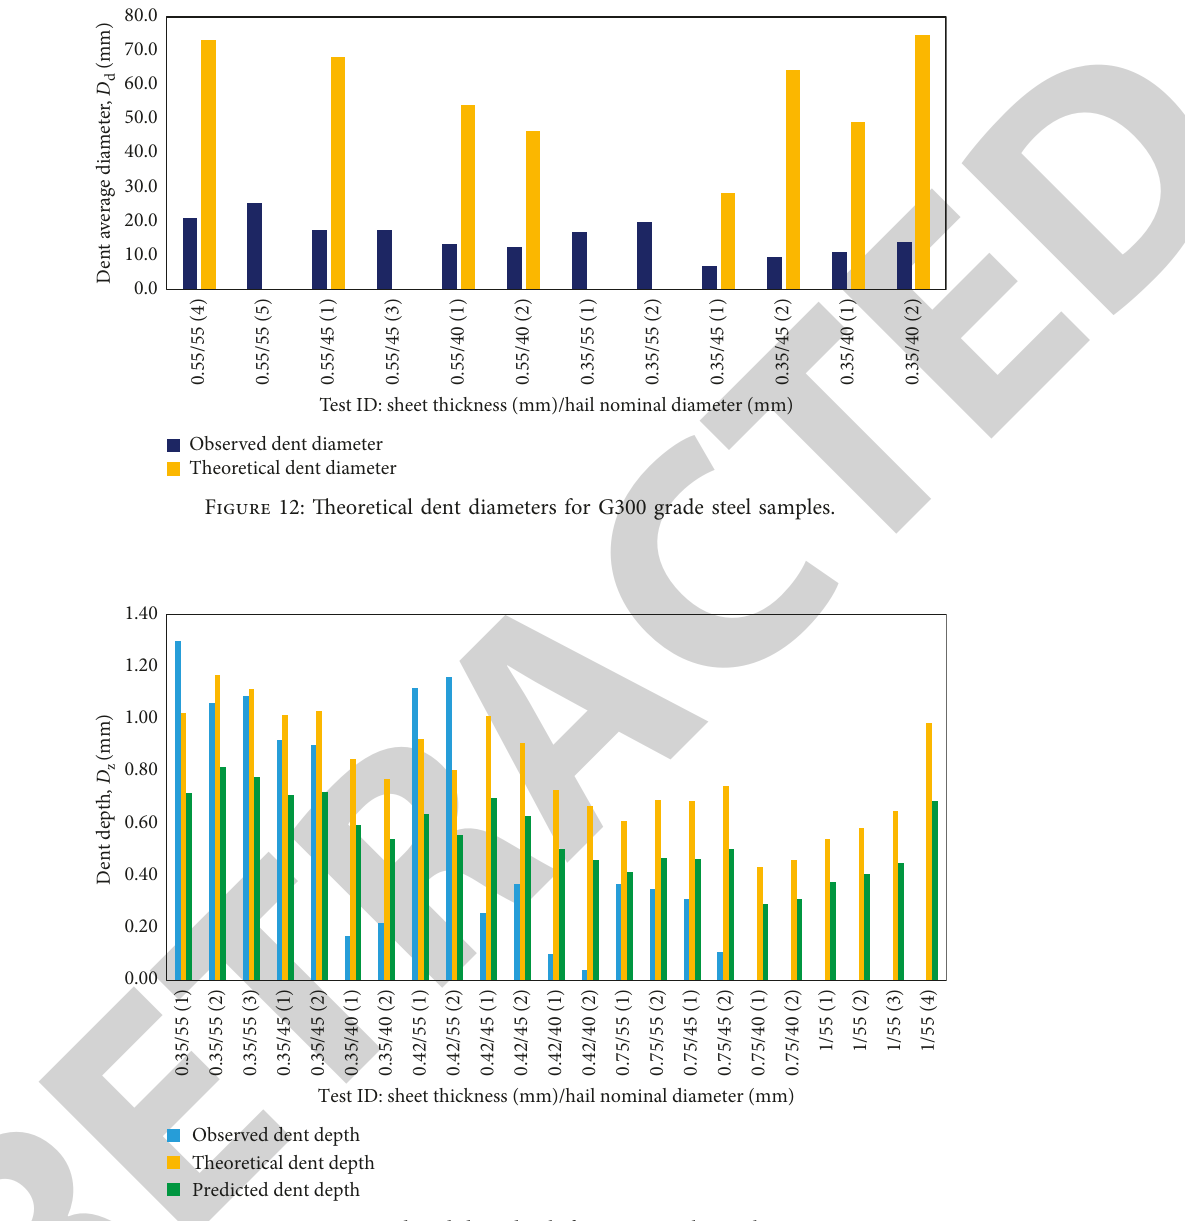
Figure 13: Predicted dent depth for G550 steel